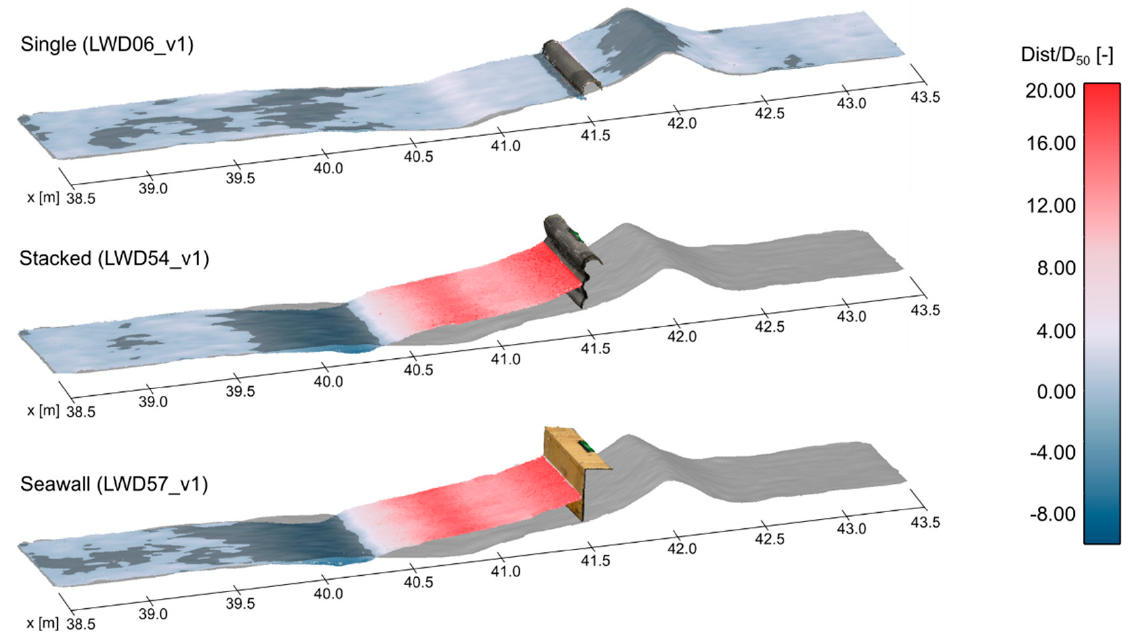
Figure 10. Beach profile changes for each structure configuration in relation to the beach profile with No Structures (grey) under medium wave conditions (Tp = 2.17 s, Hs = 0.15 m).